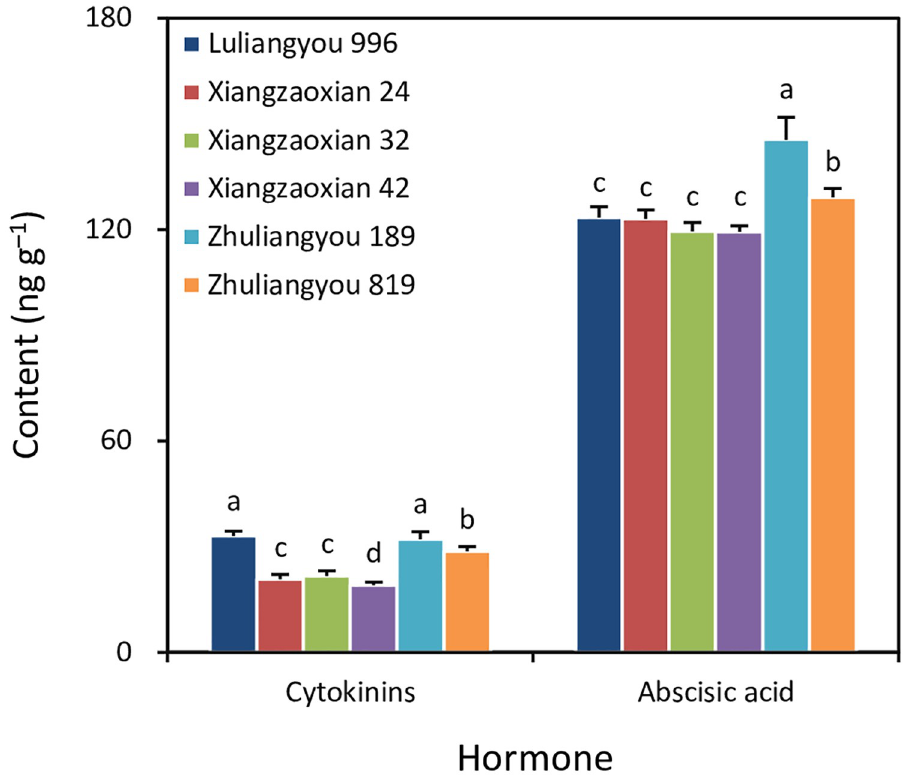
Fig 3. Grain cytokinin and abscisic acid contents during the rapid grain-filling period of six early-season rice cultivars. Each column is the mean of three replicates. Error bars show standard errors. Means not sharing any letter are significantly different by the LSD test at the 0.05 probability